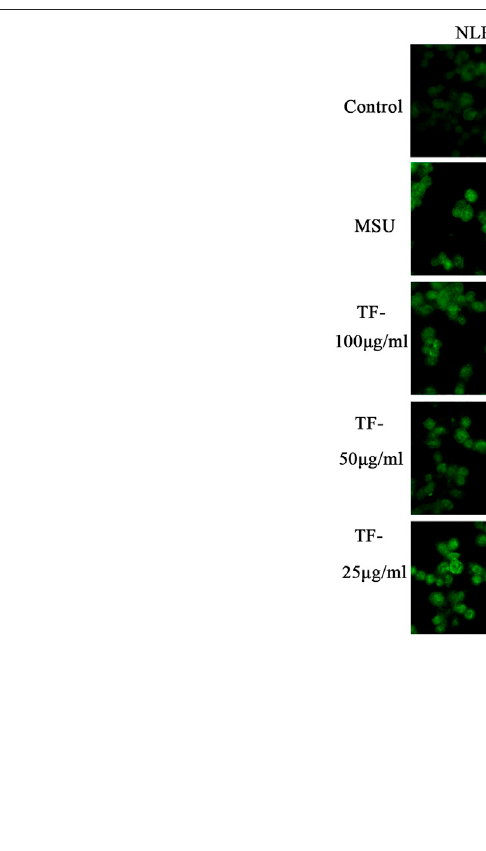
Frontiers in Pharmacology |